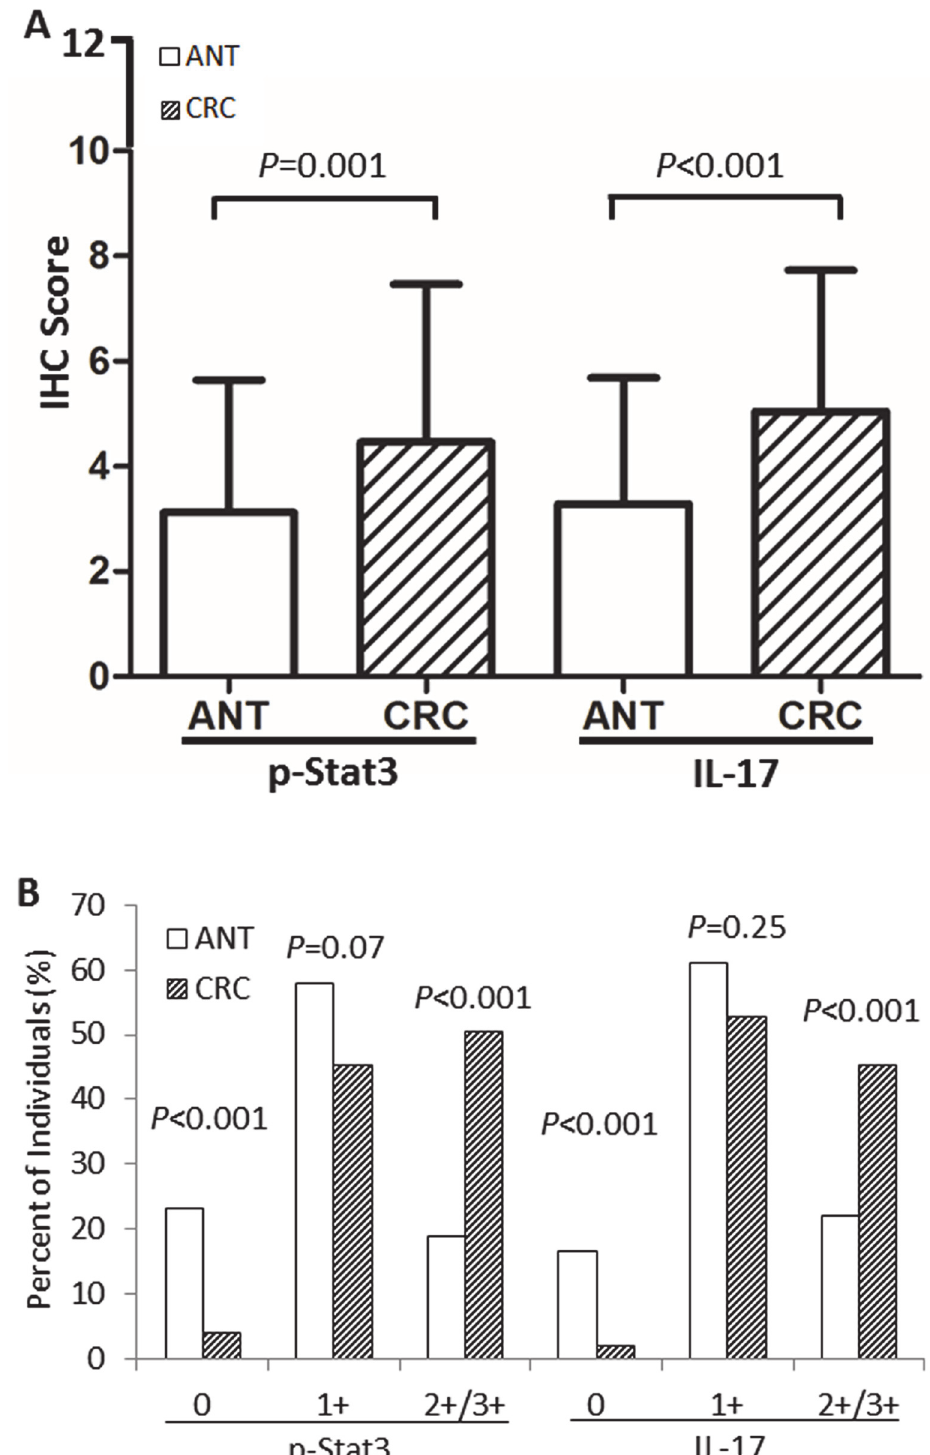
Fig 2. CRC tissues show over-phosphorylation of Stat3 (p-Stat3) and overexpression of IL-17 when compared with ANT. (A) Based on the scoring criteria (Table 1), pooled scores for p-Stat3 or IL-17 are compared between CRC and ANT individuals using t-test and the data are expressed as mean ± standard deviation (M ± SD). As seen, constitutive p-Stat3 is higher in CRC than in ANT (M ± SD, 4.5 ± 3.0 vs 3.1 ± 2.5, P